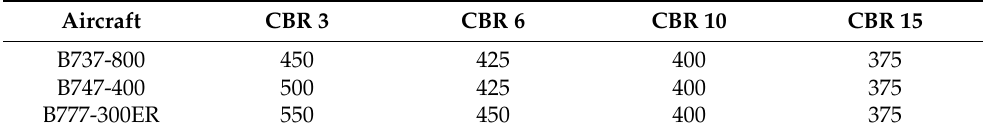
Table 4. Rigid pavement concrete thickness